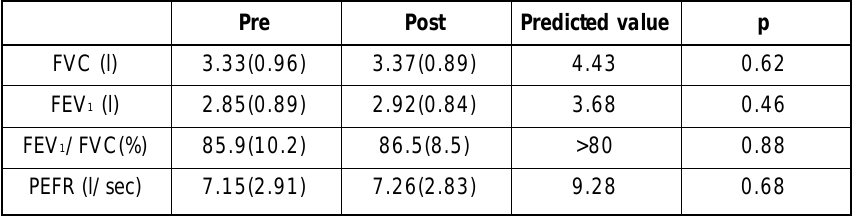
Table 1: Mean (SD) lung function parameters: FVC, FEV 1 , FEV 1 /FVC and PEFR with predicted values for all thirteen subjects.